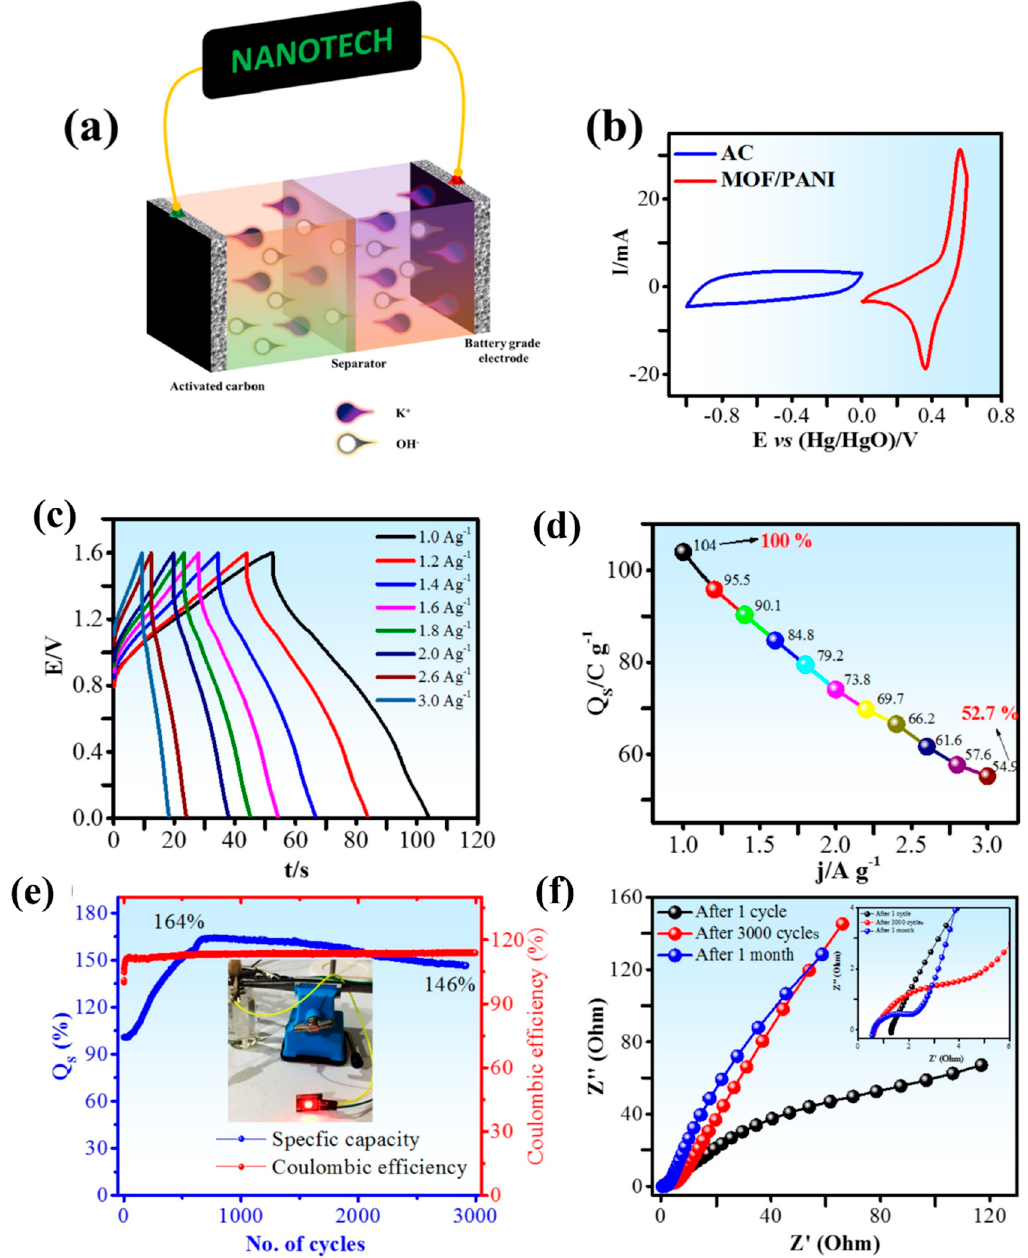
Figure 3. Pictorial illustration of the ASC device, AC//MOF/PANI ( a ); separate CV profiles of AC anode and MOF/PANI cathode ( b ); GCD curves at various densities of current ( c ); specific capacity vs. current density plot ( d ); specific capacity and columbic efficiency plot ( e ); and EIS of before stability test, after 3000 GCD cycles and one month later ( f ). Reproduced with the permission from [95]. Copyright 2020 Elsevier.